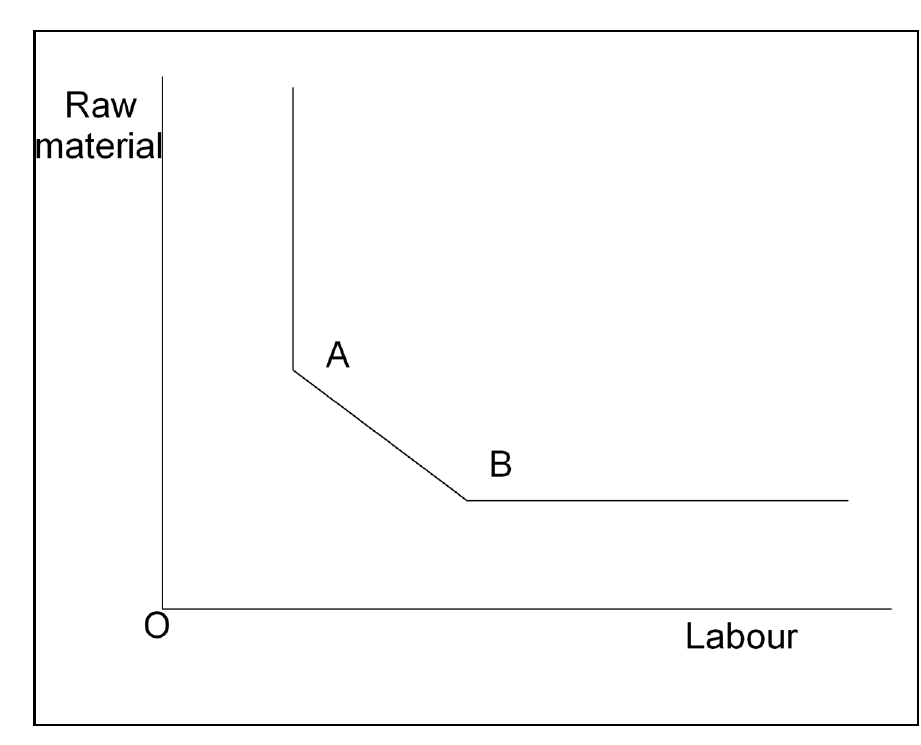
Figure 8. Steady state versus growth Source: Dornbush et al